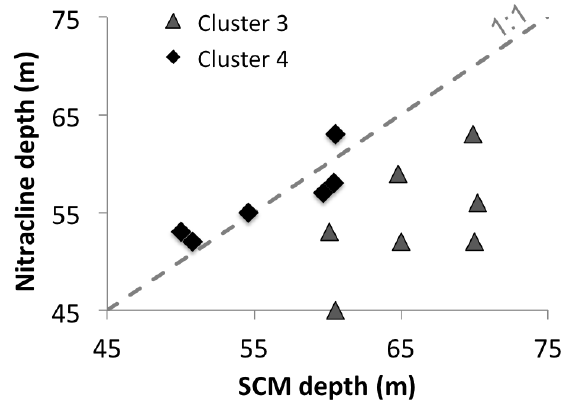
Figure 5. Relationship between the nitracline depth and the subsur- face chlorophyll a maximum (SCM) depth for samples of clusters 3 (grey triangle) and 4 (black diamond). The dashed line represents a 1 : 1 relationship. Note the SCM depth matches with the nitracline depth for cluster 4 samples. In contrast, the SCM is deeper than the nitracline depth for cluster 3